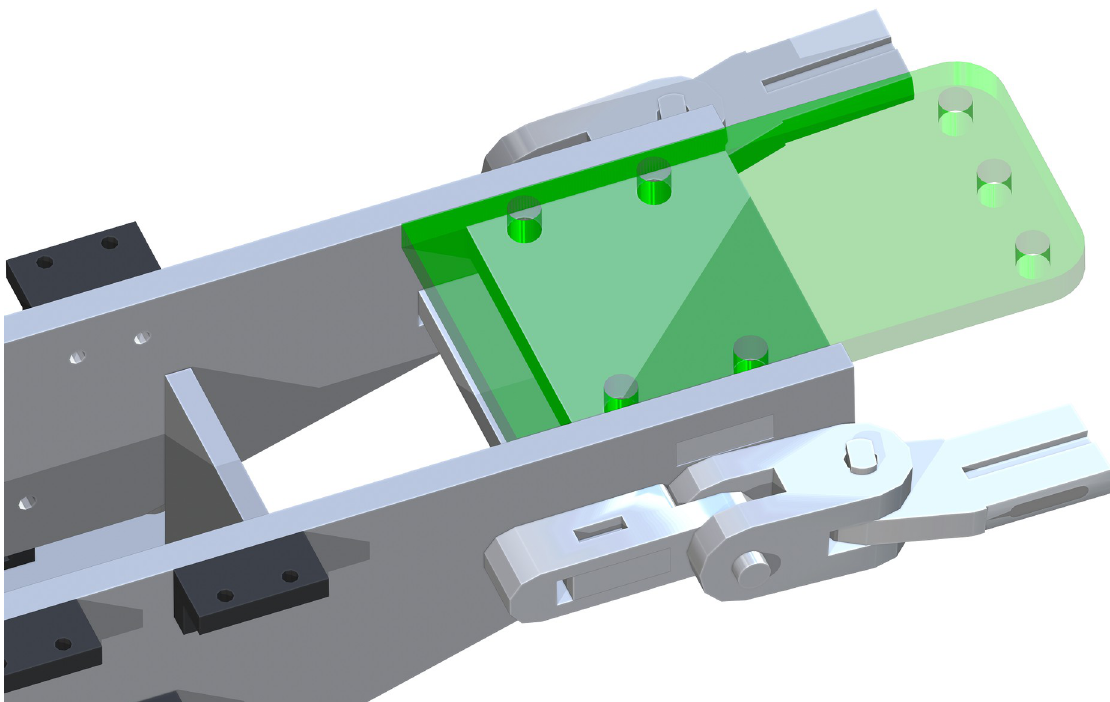
Fig 20. Addition of Peroneal Brace to the Peroneal Support.